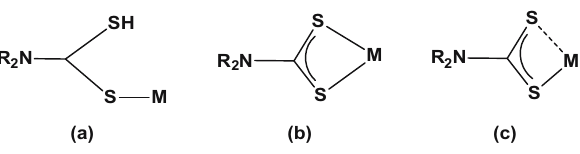
Figure 2: Di ff erent coordination modes of dihtiocarbamate complexe ( a ) monodentate, ( b ) bidentate and ( c ) anisobidentate modes [ 19